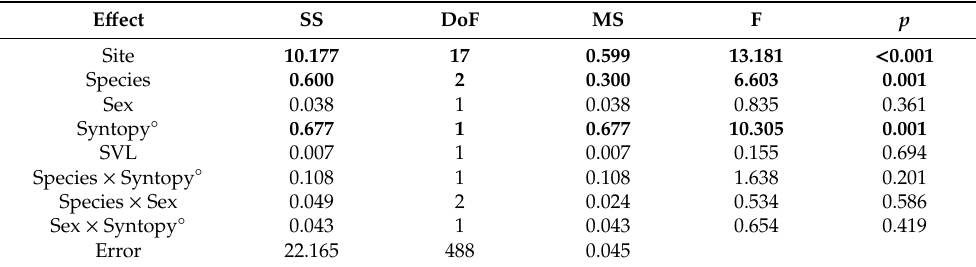
Table 2. E ff ect of site (random factor), species, sex, syntopy condition (yes / no), newt body size (SVL; covariate), and interaction terms of fixed factors on newt diet variation (V = 1 − IS; see Methods) at the study sites. The e ff ect of syntopy condition ( ◦ ) was tested on L. italicus and T. carnifex only because L. vulgaris was always found in co-occurrence with other species. Significant e ff ects are highlighted in bold. E ff ect SS